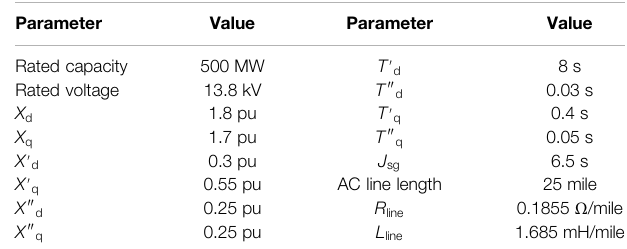
TABLE 3 | Parameters of synchronous machine and AC